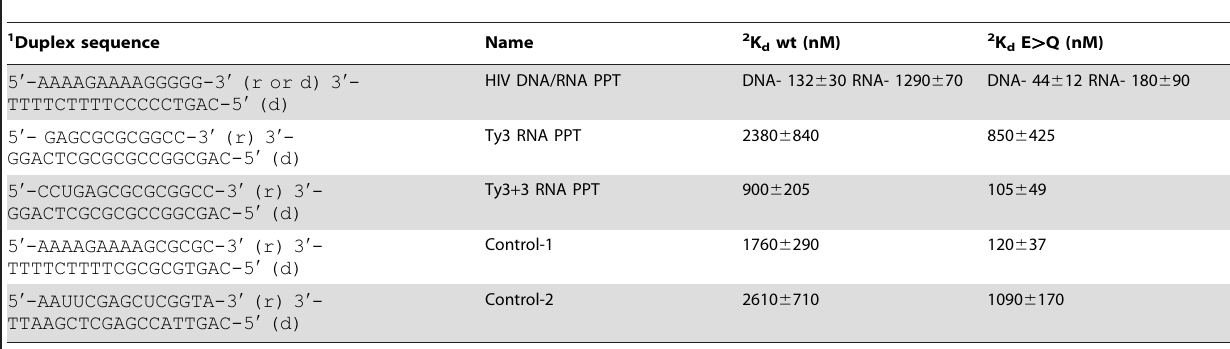
Table 2. Filter binding analysis of K d with HIV RT wild type and RNase H minus. 1 Duplex